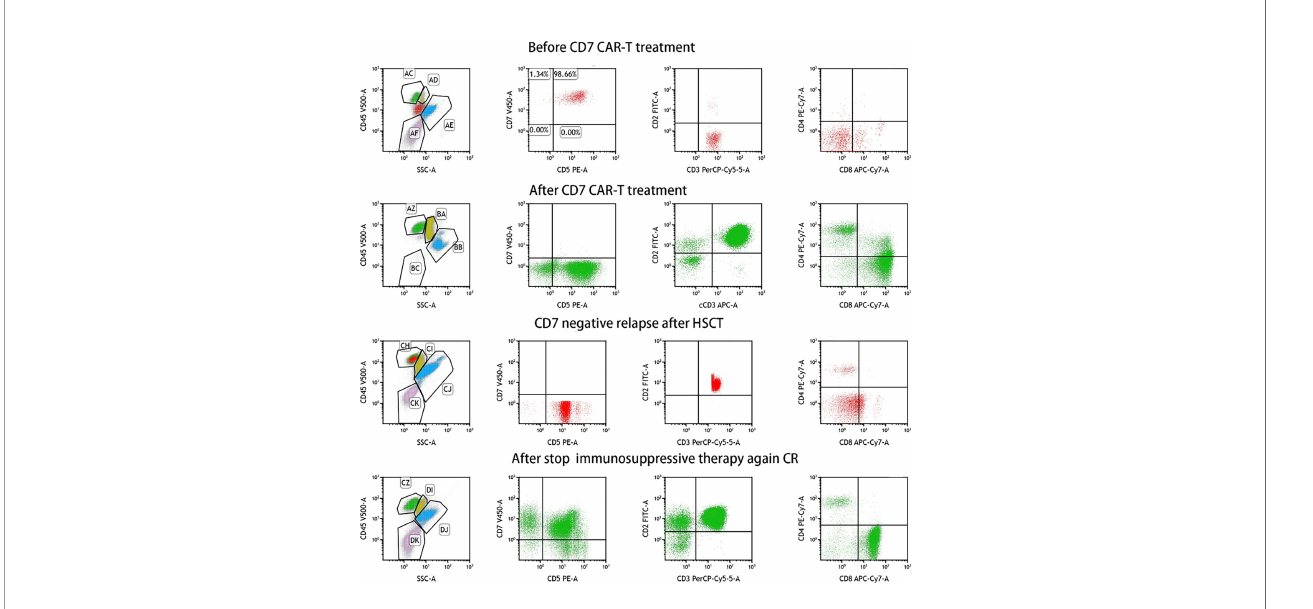
FIGURE 3 | MRD was detected by fl ow cytometry during CD7 CAR-T therapy bridging to HSCT.